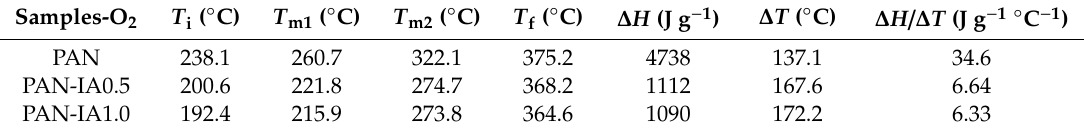
Table 4. DSC parameters of PAN homopolymer and PAN-IA copolymers in an air atmosphere. Samples-O